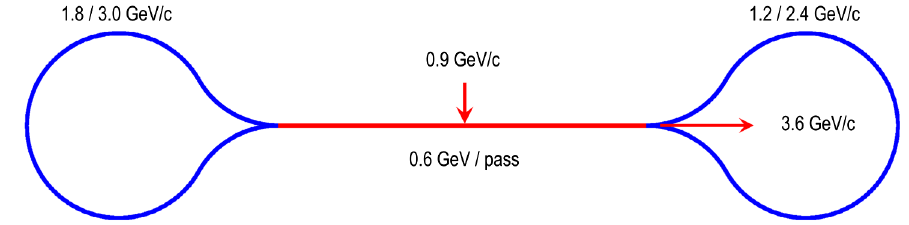
FIG. 1. Schematic layout of a 4.5-pass 3 : 6 GeV =c muon